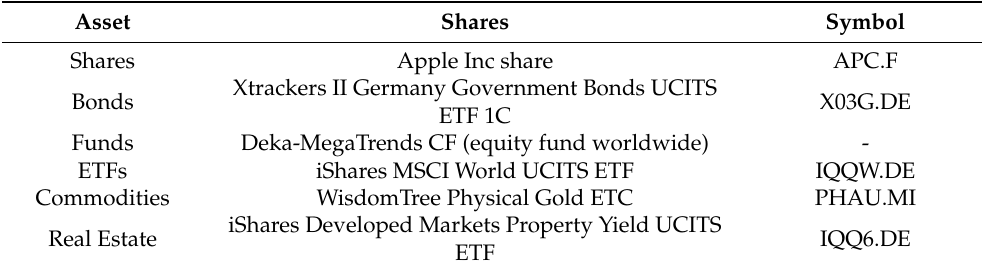
Table 4. The selection of the six investment products for the testing of the trading strategy .